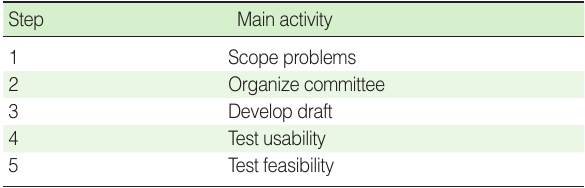
Table 2. Five steps of developing patient decision aids